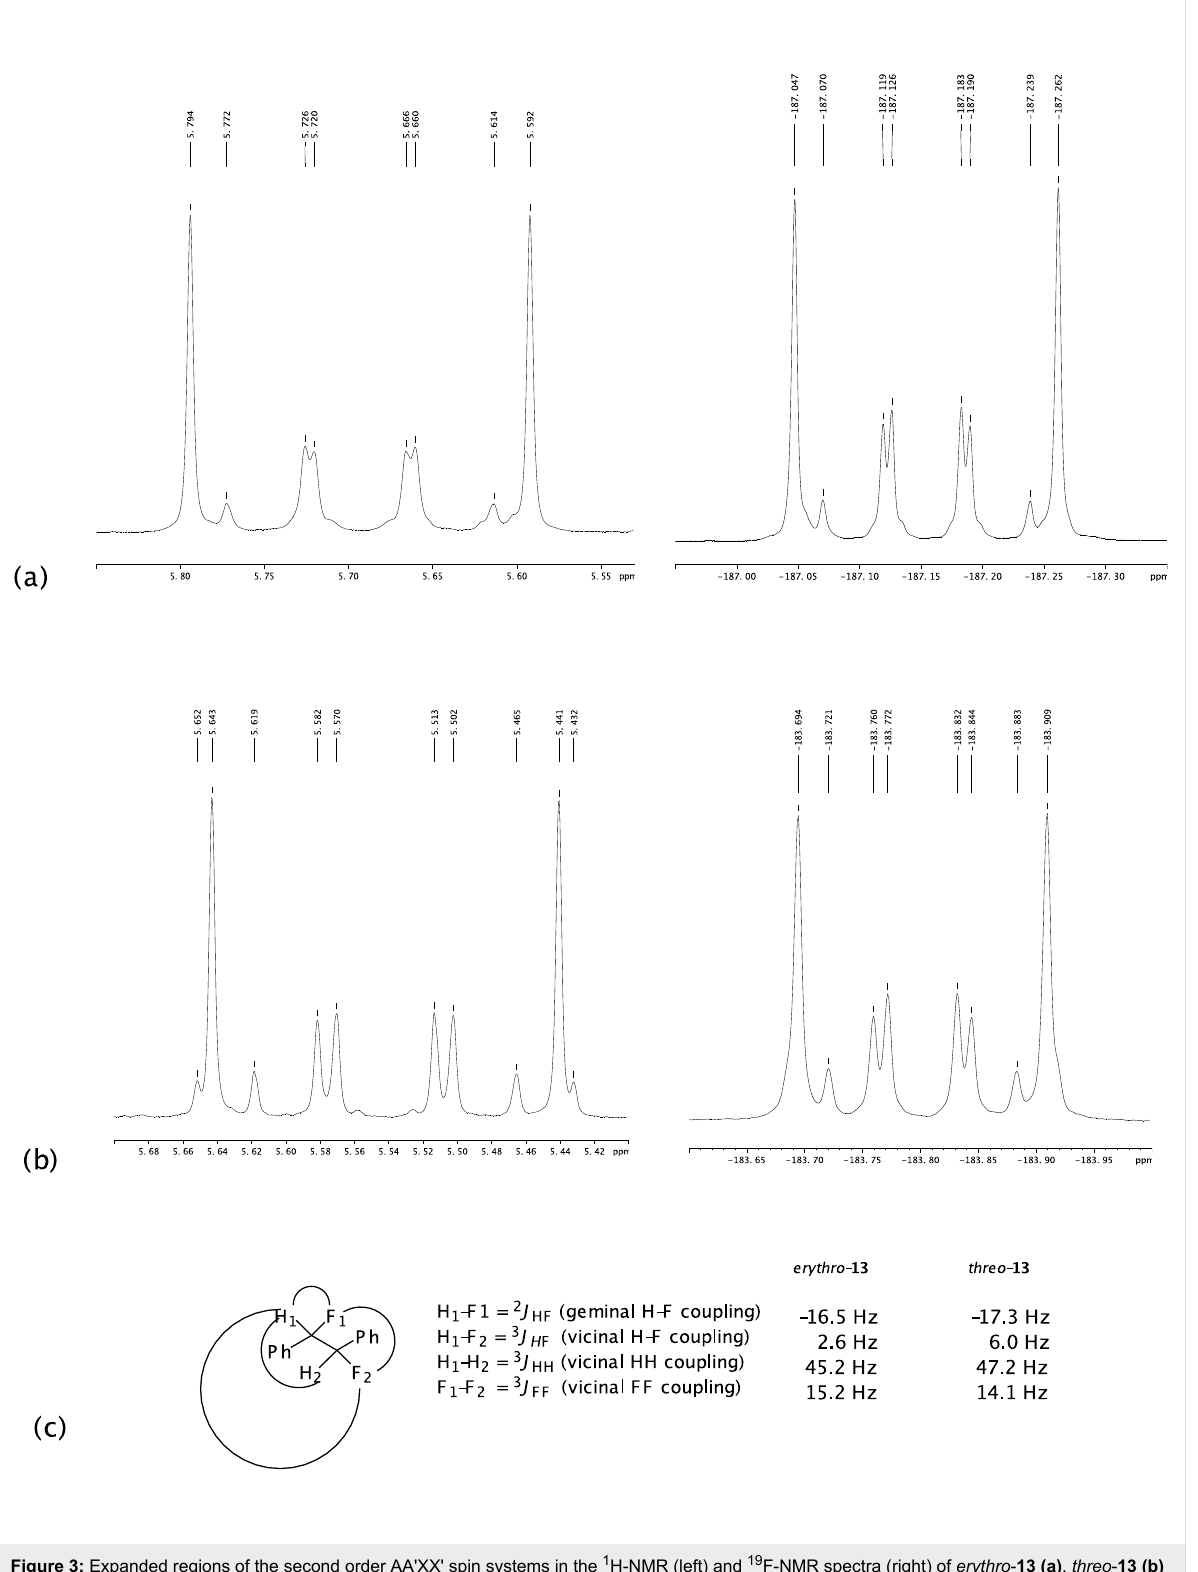
Figure 3: Expanded regions of the second order AA'XX' spin systems in the 1 H-NMR (left) and 19 F-NMR spectra (right) of erythro - 13 (a) , threo - 13 (b) and the four individual coupling constants for the central 1 H and 19 F nuclei are given in (c)